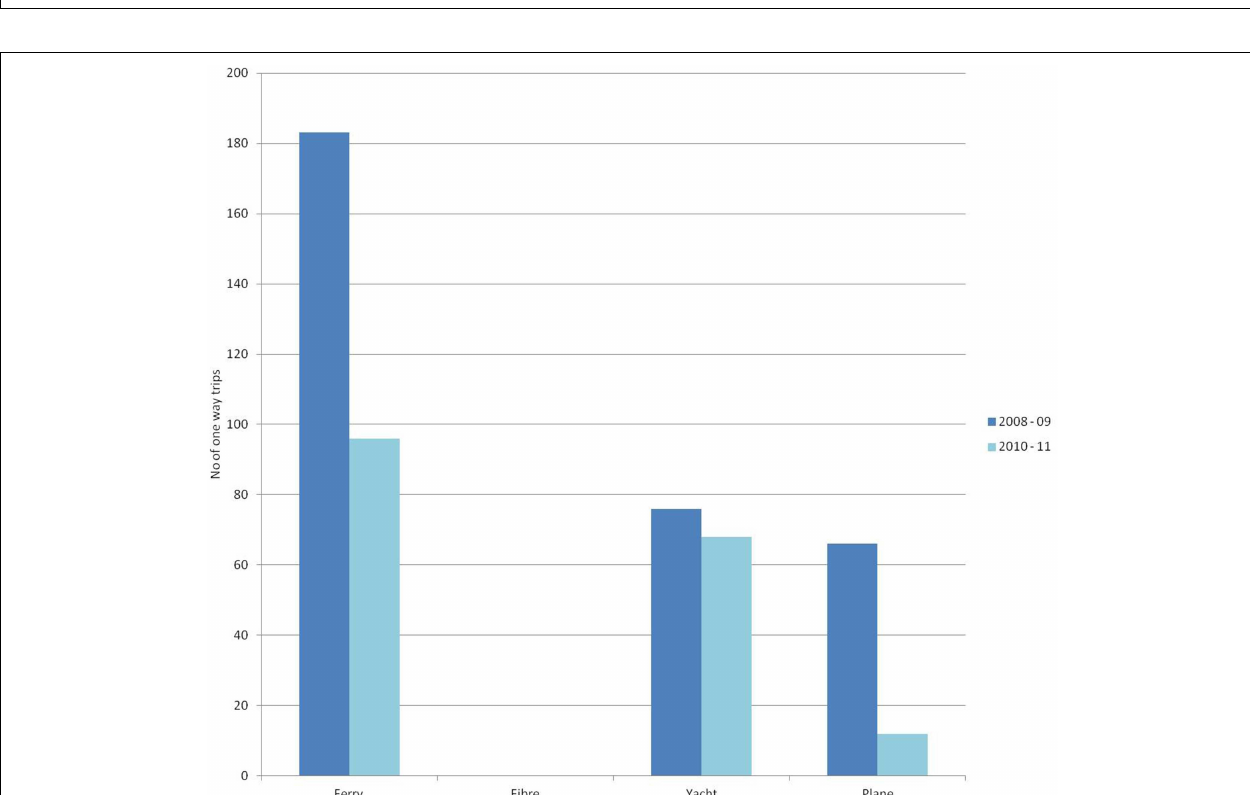
FIGURE 6 | Number of one-way trips made (in 1 year) by Solodamu villagers outside of Kadavu.